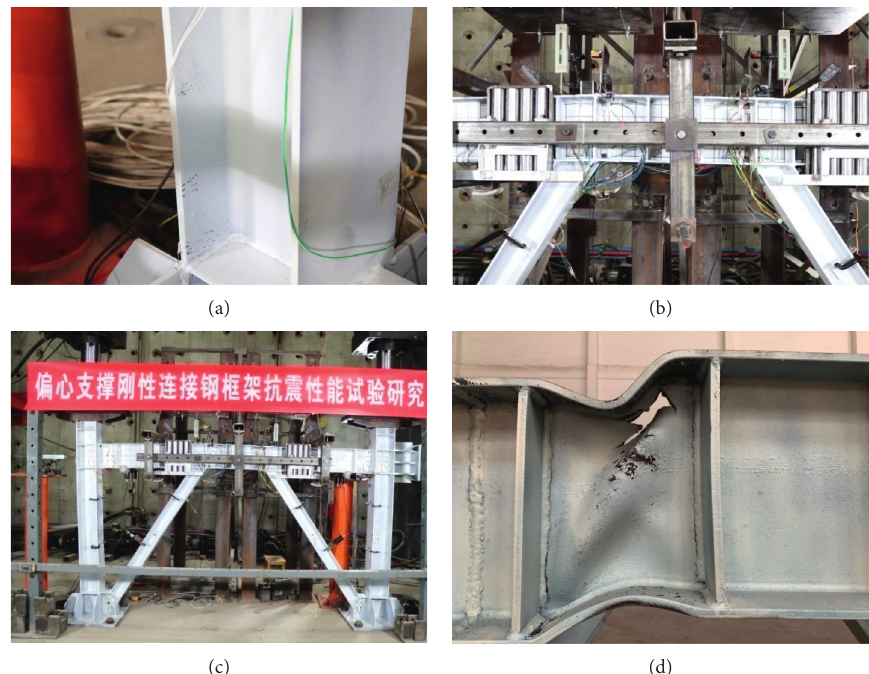
y . (b) Deformation at 6 δ y . (c) Deformation at 7 δ y .